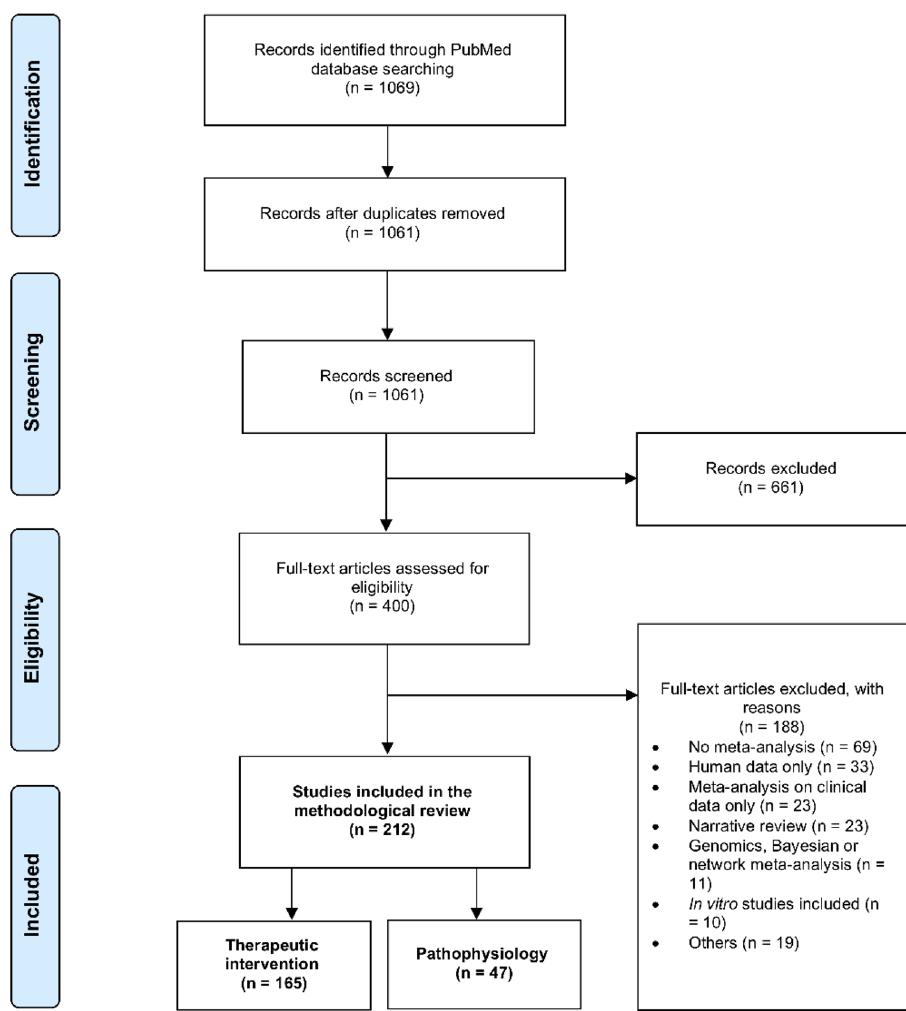
Figure 1. Selection process of preclinical systematic reviews with meta-analyses. Adapted from the PRISMA flow diagram 18